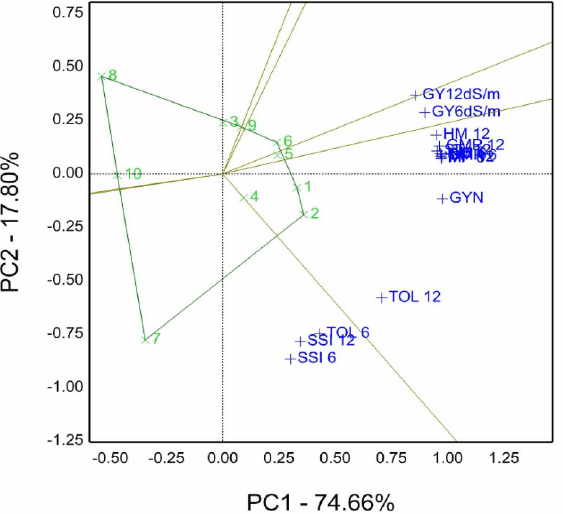
Figure 12. Which − won − where (GSTI) biplot of wheat grain yield gm per row at control at 0.4 dS/m (GYN), grain yield gm per row at 6.0 or 12.0 dS/m (GY 6.0, 12.0 dS/m), and salinity tolerance/susceptible indices (calculated at control with 0.4 dS/m and 6.0 dS/m and 12.0 dS/m) of ten genotypes in the 2020/21 season. TOL, tolerance index; MP, mean productivity; STI, stress tolerance index; GMP geometric mean productivity; HM, harmonic mean; SSI, stress susceptibility index. Based on the means vs stability GSTI biplot, ten entries evaluated under three salinity treatments by simulated lysimeter in the 2020/21 season are illustrated in Figure 13. The rank commences from genotype 2 followed by 1, 5, 6, and 4 placed on the average tester coordination line (ATC blue line with an arrow). Additionally, genotypes 2 and 1 would show the best mean performance and stability. However, genotypes 7 and 8 are far away from the ATC; thus, they are unstable genotypes.